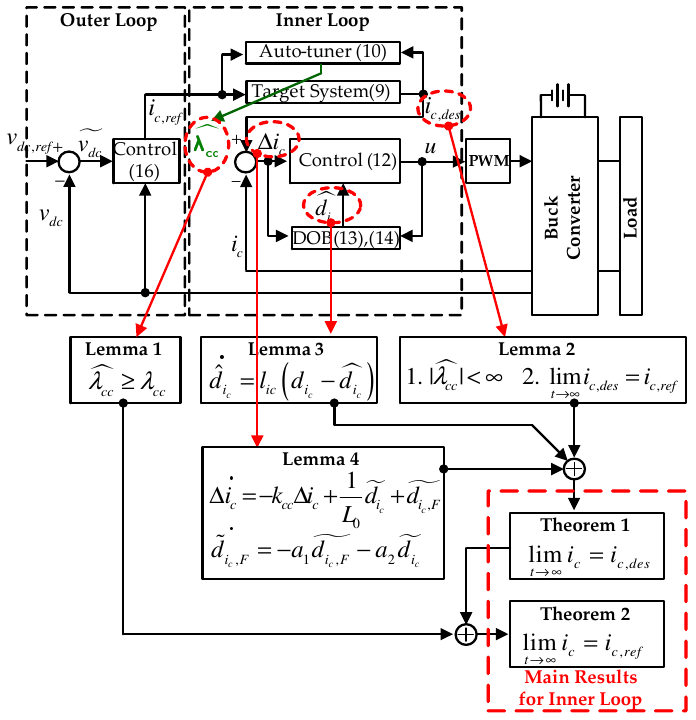
Figure 4. Inner loop